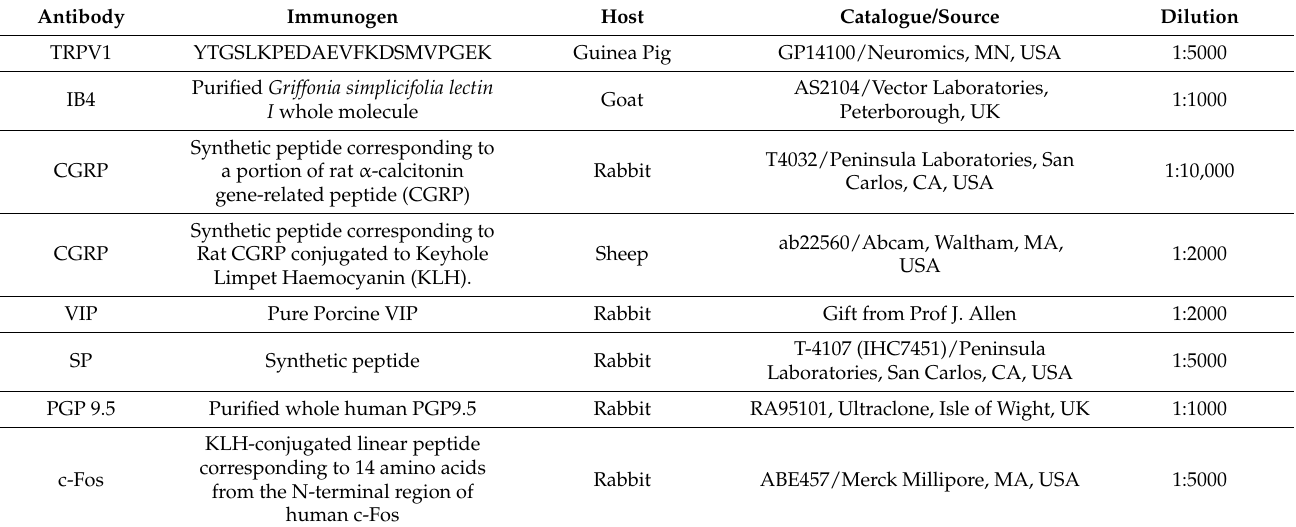
Table 2. Primary antibodies used, sources and